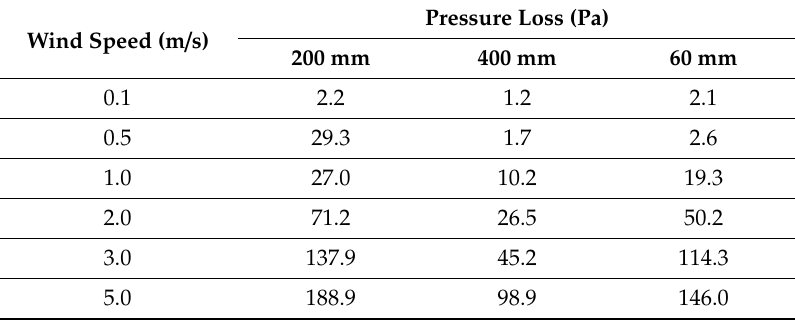
Table 5. Di ff erential pressure characteristics of the ACF for di ff erent wind